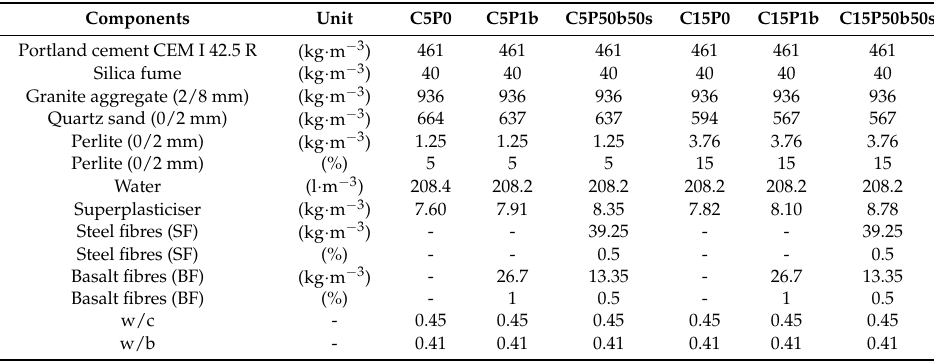
Table 3. Composition of concrete